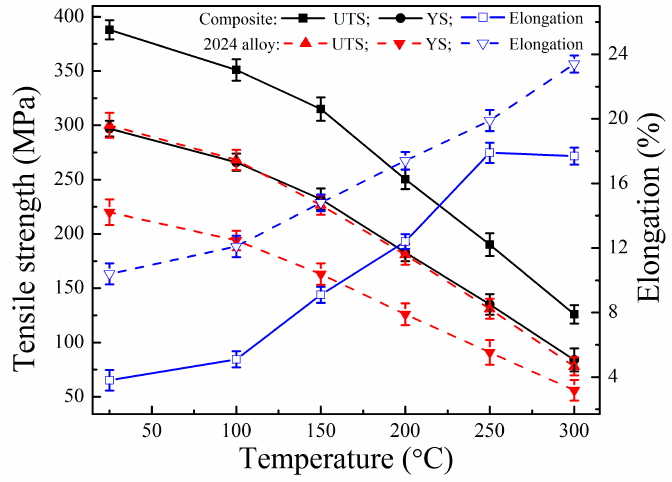
Figure 5. Variations of the mechanical properties with the testing temperature.